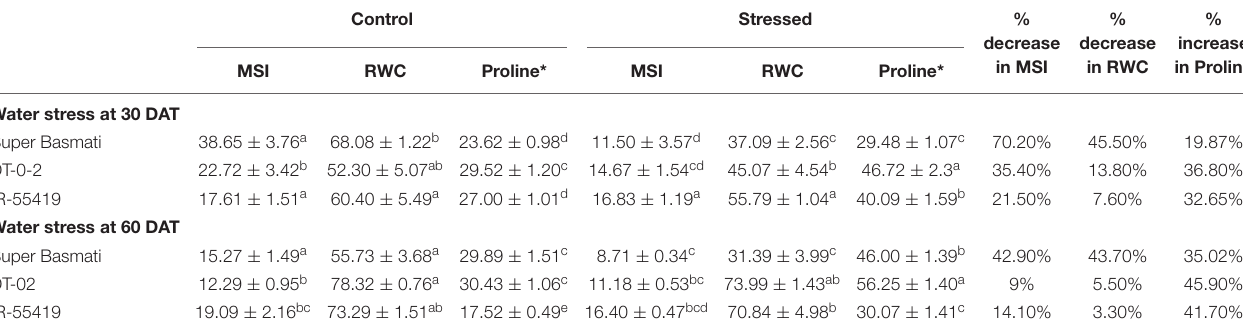
Control Stressed %